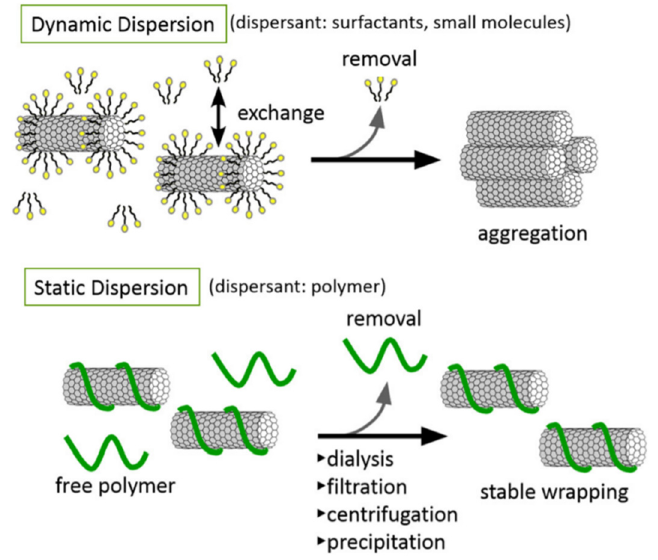
Figure 1. Schematic of a dynamic and static CNT dispersion [33]. Figure reprinted with permission under CC 3.0.